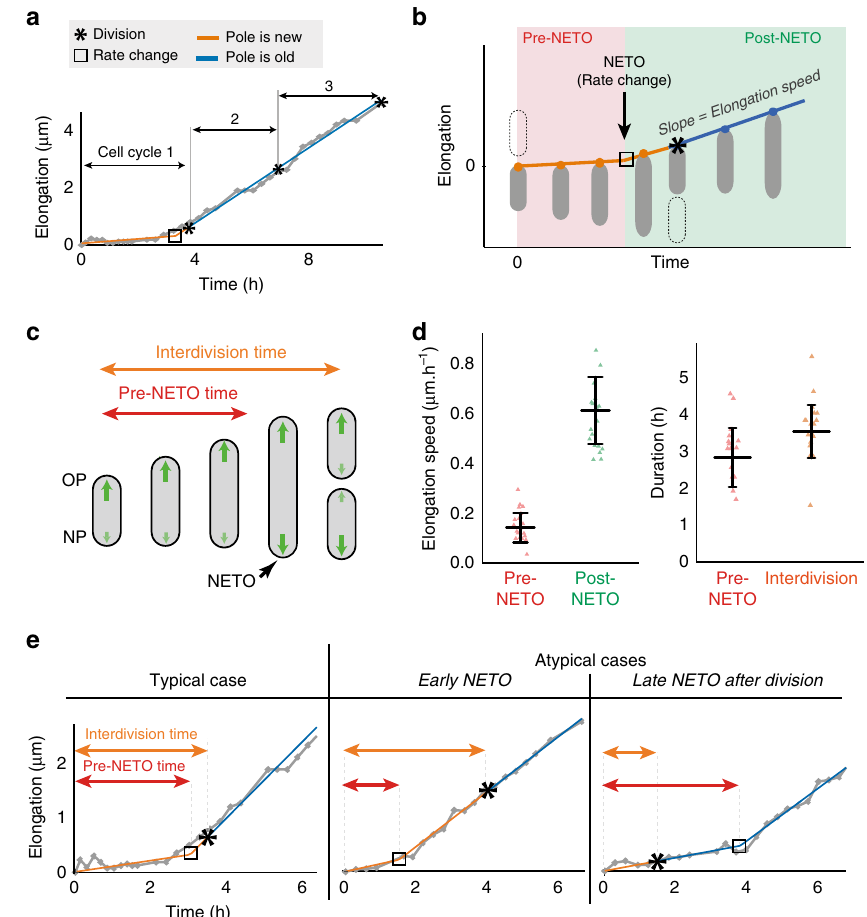
Fig. 2 Biphasic pole growth: NETO and cell division are independent events. a Elongation of a representative newborn pole through three generations measured by time-lapse AFM. Gray: AFM data; orange/blue: bilinear fi t. See Supplementary Fig. 4. b Schematic of biphasic growth of a newborn pole with a rate change (NETO). c Schematic of biphasic NETO growth of a cell over one cell cycle. d Left: elongation speeds of newborn poles during the pre-NETO phase (slow or no growth) and the post-NETO phase (fast growth). Right: pre-NETO time and interdivision time. Data from time-lapse AFM images (20 poles). Bars indicate averages and standard deviations. e Typical elongation curve of a newborn cell pole (left) and atypical curves with early NETO before division (center) and late NETO after division (right). Each curve corresponds to one of the data points in d . Gray: AFM data; orange/blue: bilinear fi